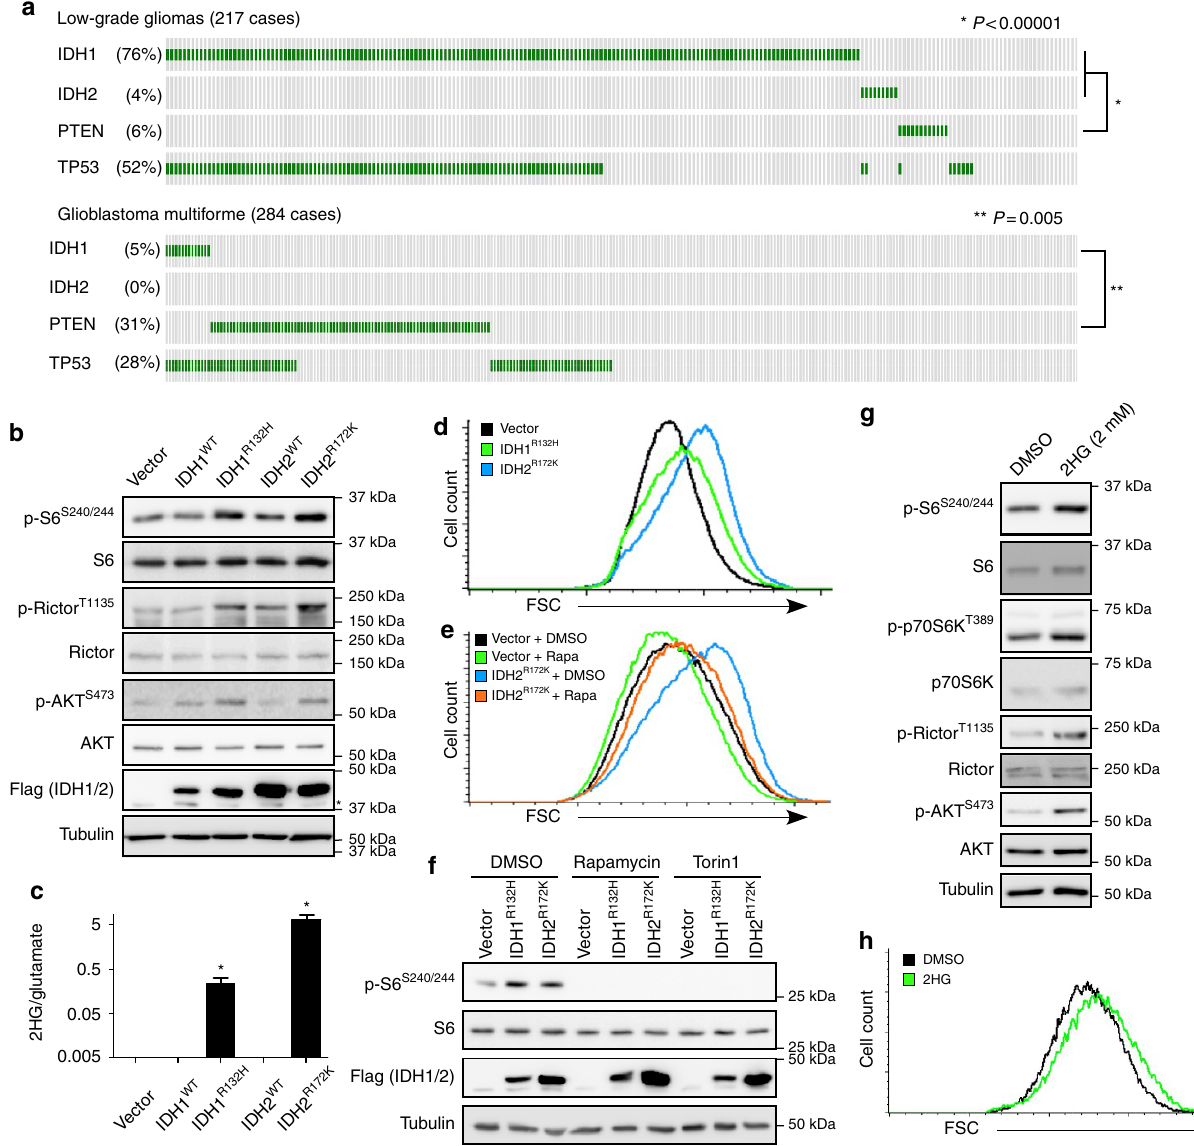
Figure 1 | Activation of mTOR signalling by 2HG-producing IDH1/2 gain-of-function mutations. ( a ) IDH1/2 and PTEN mutations are mutually exclusive in low-grade gliomas and glioblastomas. Data were obtained from The Cancer Genome Atlas (TCGA). Each vertical lane represents one patient; green lines depict the presence of a mutation. Statistical analysis was performed using the Fisher’s exact test. ( b ) mTOR pathway activation in MEFs p53 (cid:2) / (cid:2) cells expressing wt versus mutant IDH. Flag-tagged IDH was retrovirally transduced into MEFs p53 (cid:2) / (cid:2) cells, and whole-cell lysates were harvested at 9 days post selection. Asterisk denotes a nonspecific band recognized by the antibody. ( c ) Intracellular accumulation of 2HG on IDH1/2 mutant expression as in b . 2HG levels were normalized against glutamate levels. Asterisks denote a statistical difference between IDH1/2 mutated cells and empty vector cells, two- sided t -test P o 0.0001 (graph represents three independent experiments). Error bars represent standard deviation. ( d ) Increased cell size associated with mutated IDH1/2 expression. FSC measurement in FACS analysis demonstrates the shift in cell size in MEFs p53 (cid:2) / (cid:2) cells expressing IDH1 R123H (green line) or IDH2 R172K (blue line) compared with empty vector-infected cells (black line). A total 250,000 cells were counted for each condition and graph is representative of four independent experiments. ( e ) Inhibition of mTORC1 rescues the increased cell size in IDH2 R172K mutant cells. MEFs p53 (cid:2) / (cid:2) cells expressing IDH2 R172K or empty vector were treated with 25nM rapamycin for 16h before FACS analysis. A total 250,000 cells were counted for each condition. ( f ) Rapamycin or Torin1 treatment prevents mTORC1 activation in cells expressing IDH1/2 mutants. MEFs p53 (cid:2) / (cid:2) cells expressing IDH1/2 mutants were treated with 100nM rapamycin or 250nM Torin1 for 24h and whole-cell lysates blotted for markers of mTORC1 activation. ( g ) 2HG stimulates the mTOR pathway. MEFs p53 (cid:2) / (cid:2) were treated with 2mM of octyl-2HG for 4h, and whole-cell extracts analysed by western blot. ( h ) Octyl- 2HG treatment increases cell size. MEFs p53 (cid:2) / (cid:2) cells were treated with 1mM octyl-2HG for 8h before FCS analysis by FACS. A total 25,000 cells were counted for each condition and graph is representative of two independent experiments. cells treated with AGI-5198, an inhibitor of mutated IDH1 mTORC1/2 inhibitor Torin1 abrogated S6 phosphorylation on (ref. 37), failed to activate mTORC1 (Supplementary Fig. 1e), serines 240 and 244 in IDH1/2 mutant-expressing cells, suggesting that oncogenic IDH1-mediated production of 2HG is confirming the activation of mTORC1-dependent p70S6K by responsible for mTOR stimulation. 2HG-producing mutants (Fig. 1f). Expression of IDH1 R132H in NATURE COMMUNICATIONS|7:12700|DOI: